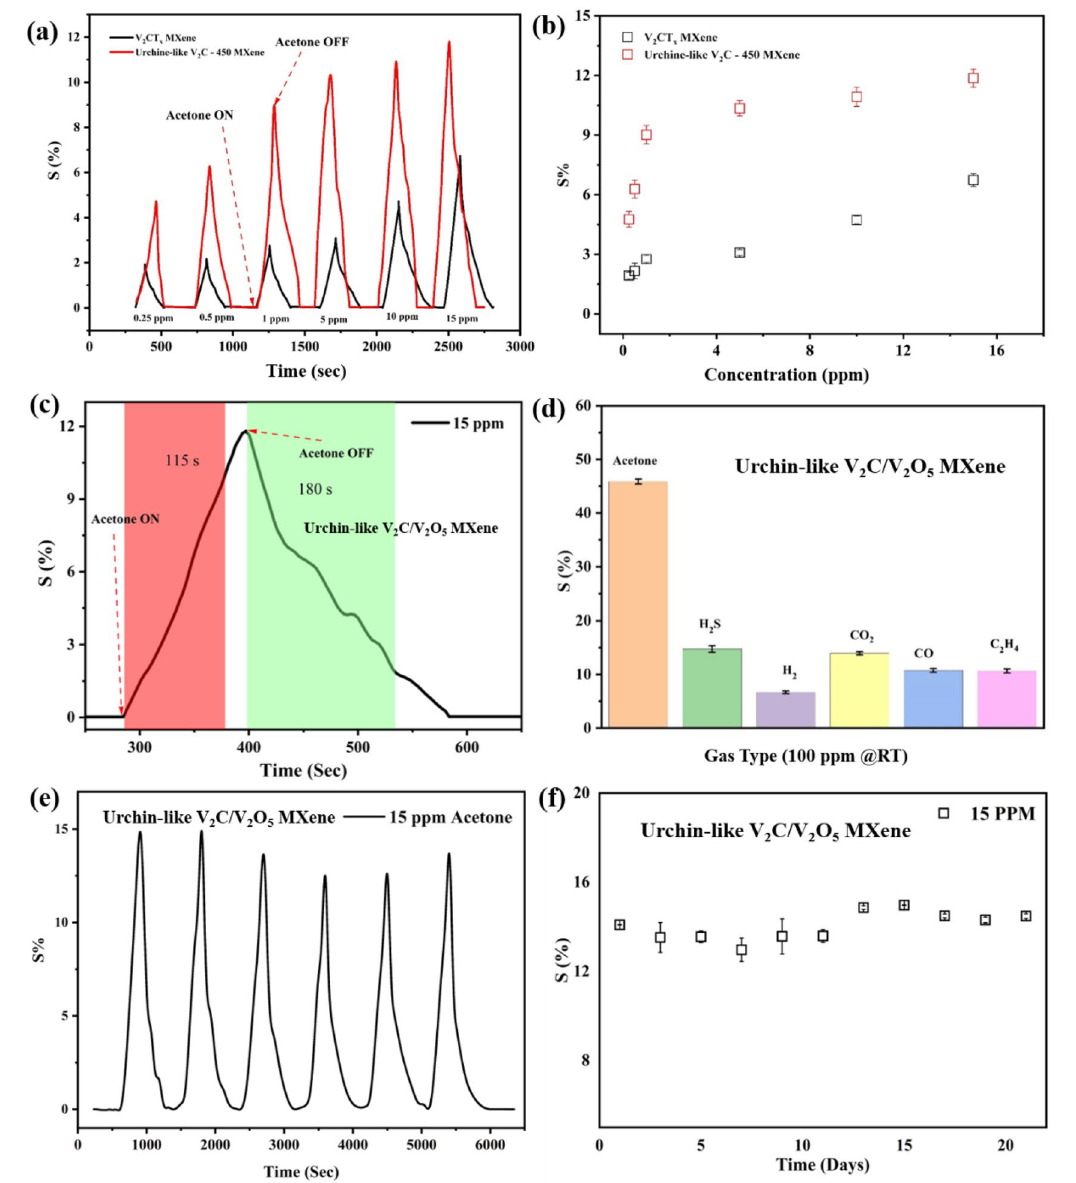
Figure 7. ( a , b ) Response transients of V 2 CT x MXene and urchin-like V 2 CT x /V 2 O 5 MXene sensors toward acetone vapor (0.25–15 ppm) tested at RT; ( c ) responses of pristine V 2 CT x MXene and urchin-like V 2 CT x /V 2 O 5 MXene sensors at different acetone vapor concentrations; ( c ) response-recovery plot of urchin-like V 2 CT x /V 2 O 5 MXene sensor; ( d ) selectivity test of urchin-like V 2 CT x /V 2 O 5 MXene sensor for 100 ppm of different gases; ( e ) repeatability and ( f ) long-term stability (21 days) tests for urchin-like V 2 CT x /V 2 O 5 MXene sensor toward 15 ppm acetone at RT (23